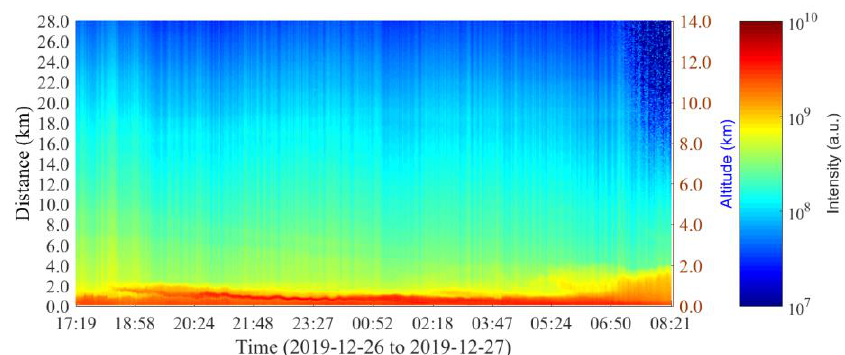
Figure 11. Time-spatial map of the glued atmospheric backscattering lidar curve, which consists of the lidar signal measured by the SLidar system in the region below 1.05 km and the lidar signal measured by the pulsed lidar system beyond 1.05 km.